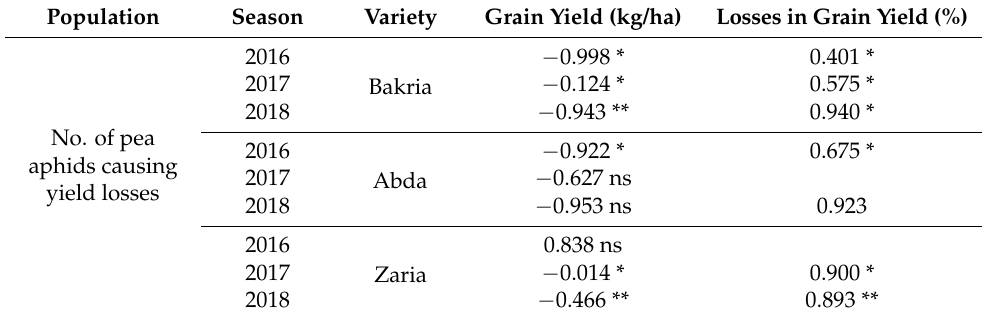
Table 4. Correlated response of pea aphid population with yield loss and grain yield/hectare. Population Season Variety Grain Yield (kg/ha) Losses in Grain Yield (%) − 0.998 * 0.401 * 2016 2017 − 0.124 * 0.575 * Bakria 2018 − 0.943 ** 0.940 * No. of pea − 0.922 2016 aphids causing Abda yield losses